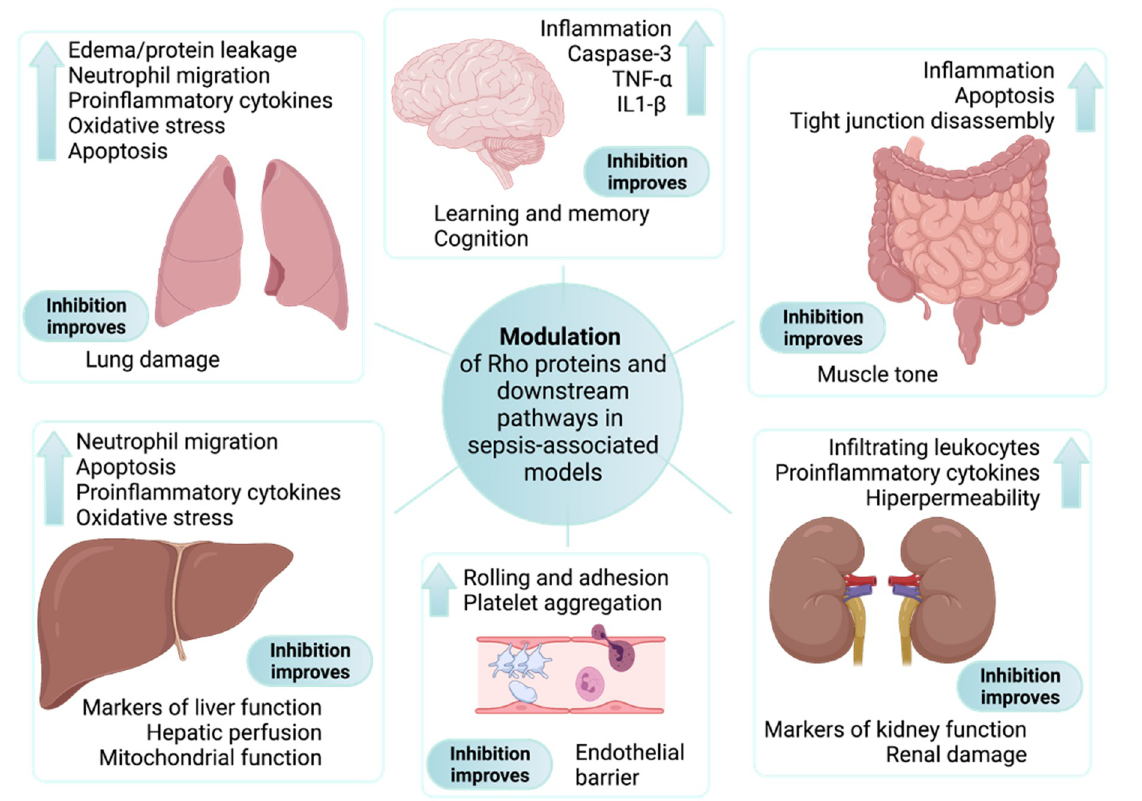
Figure 1. Main findings associated with the modulation of Rho proteins and downstream pathways in sepsis-associated experimental models. Although different Rho proteins have been explored in in vitro experimental approaches, all parameters presented inside each box were described in studies performed on animals subjected to sepsis models and treated with selective inhibitors of ROCK. Findings associated with sepsis-induced organ dysfunction are shown next to the up arrow. The main beneficial effects ascribed to inhibition of the RhoA/Rho-kinase pathway are included at the bottom of each box.